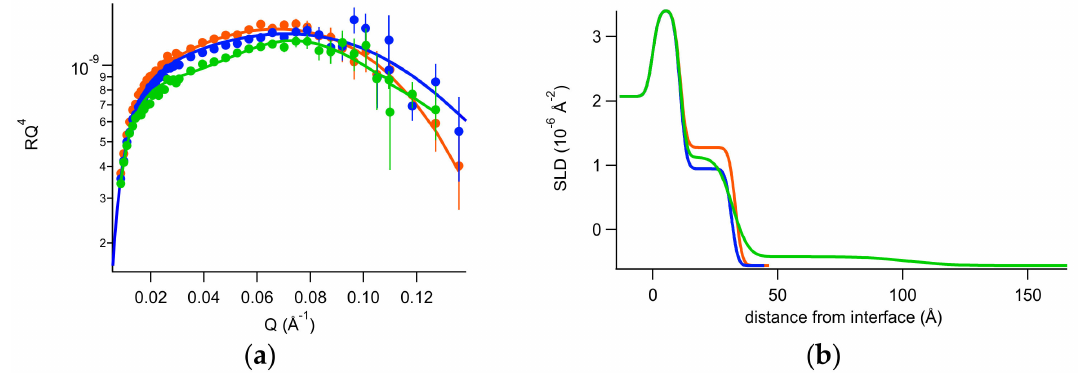
Figure 5. ( a ) Reflectivity curves (symbols), relative best fits (lines), and ( b ) obtained SLD profiles of the mucin layer investigated in H2O NaCl before (orange) and after (green) the incubation of d , l -ARGO7. Blue data correspond to the final system, investigated after